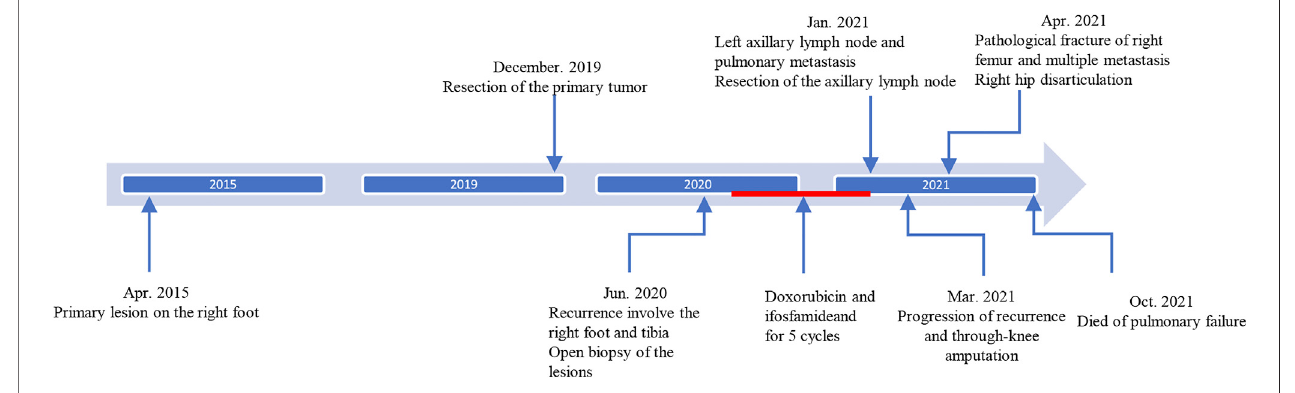
FIGURE 1 | The timeline of the